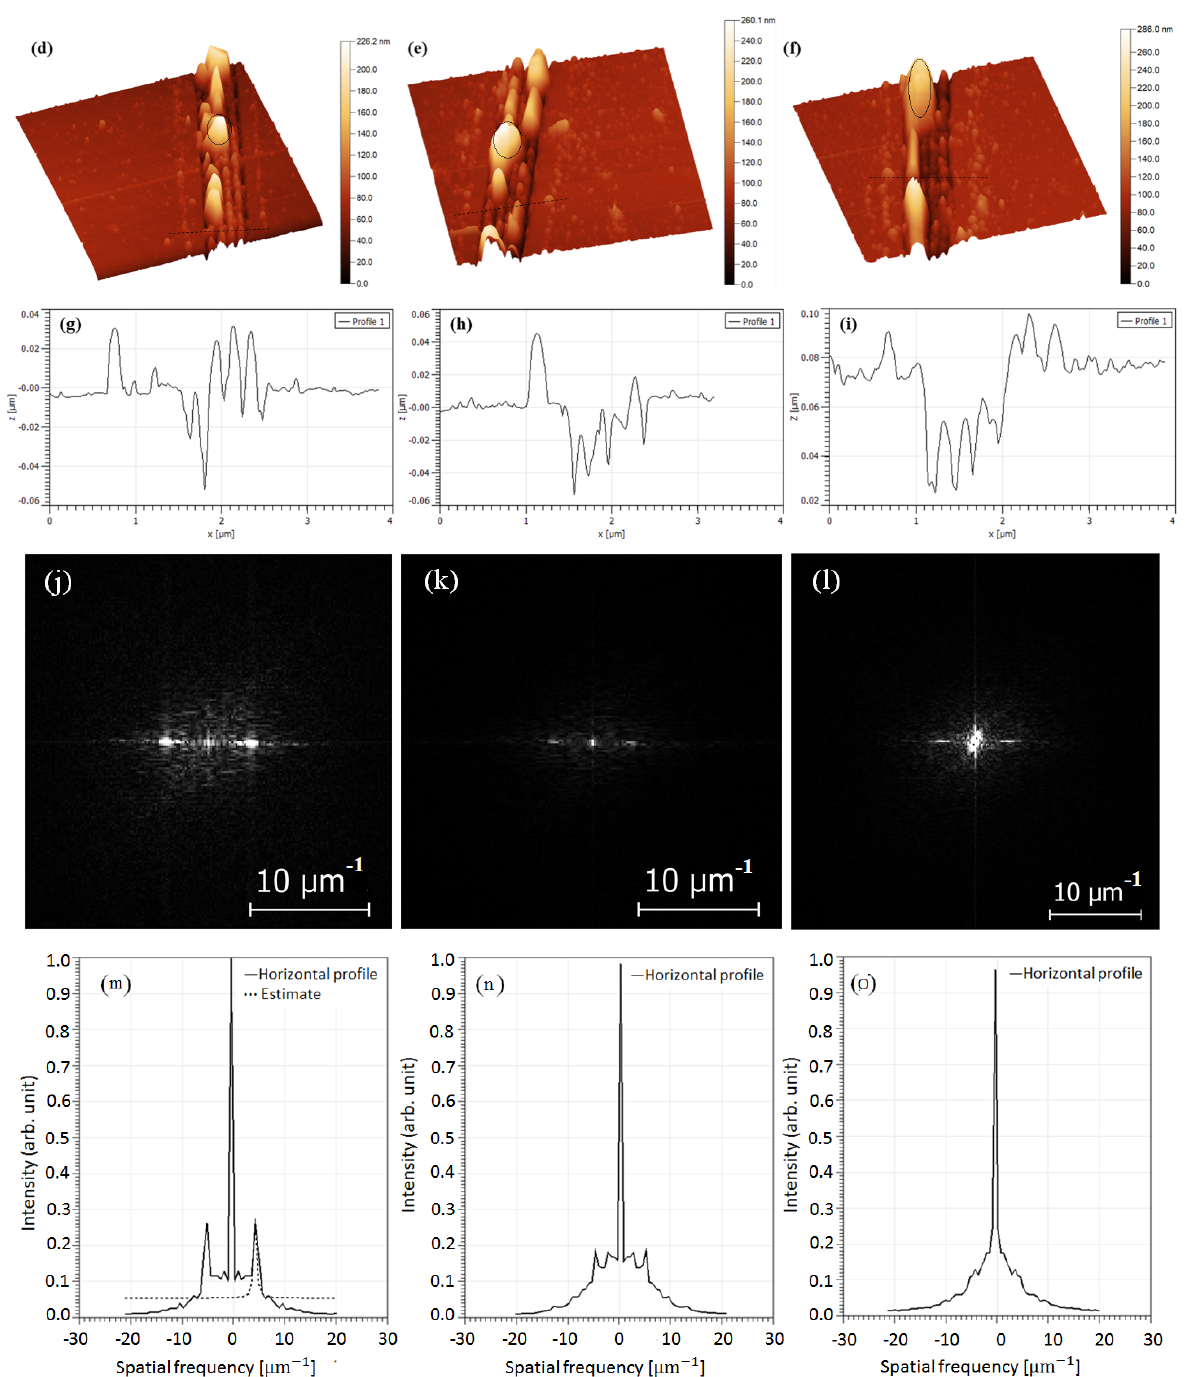
Figure 3. Representation of effect of pulse number on the morphology of the diamond surface irradiated by fs laser pulses with power of P = 19 mW ( F = 7.56 J/cm 2 ). ( a – c ) shows planar view SEM images of structures induced by N = 89, 100 and 133 pulses. ( d – f ) AFM measurements recorded in tapping mode of the ( a – c ), respectively (measured area 5 × 5 µ m 2 ). ( g – i ) represent the cross-section profile corresponding to the lines marked in ( d – f ), respectively. ( j – l ) represent 2D-fast Fourier transforms (2D-FFT) and ( m – o ) its cross section horizontal profiles, respectively. The double-arrow shows the polarization of the incident laser